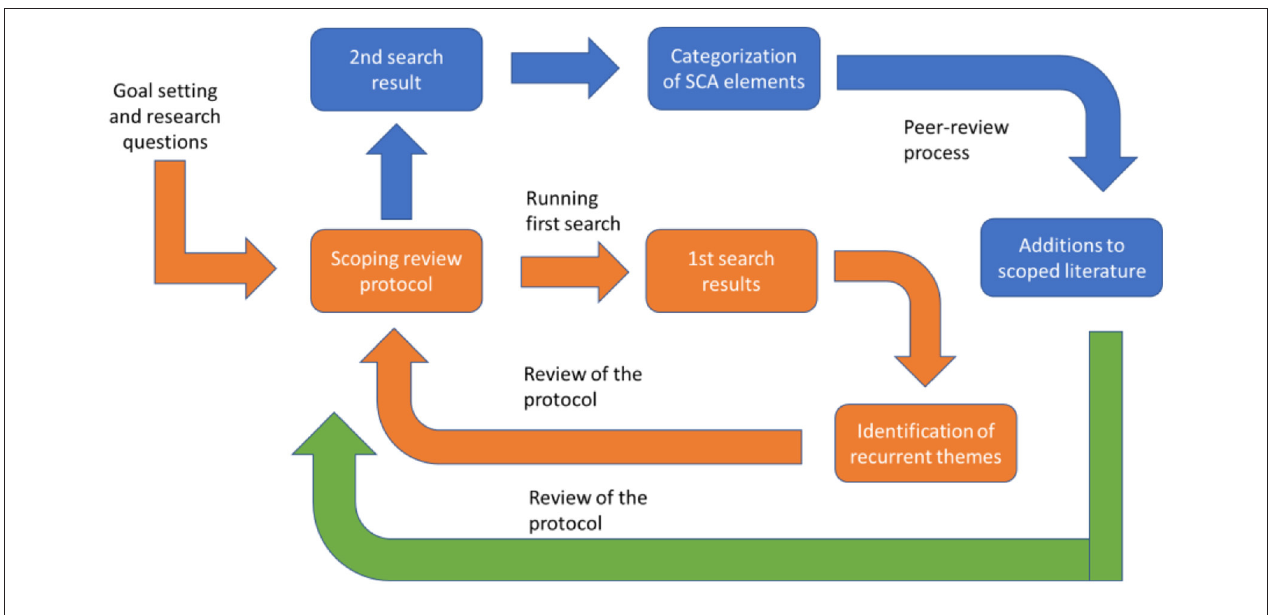
FIGURE 1 | Scoping review